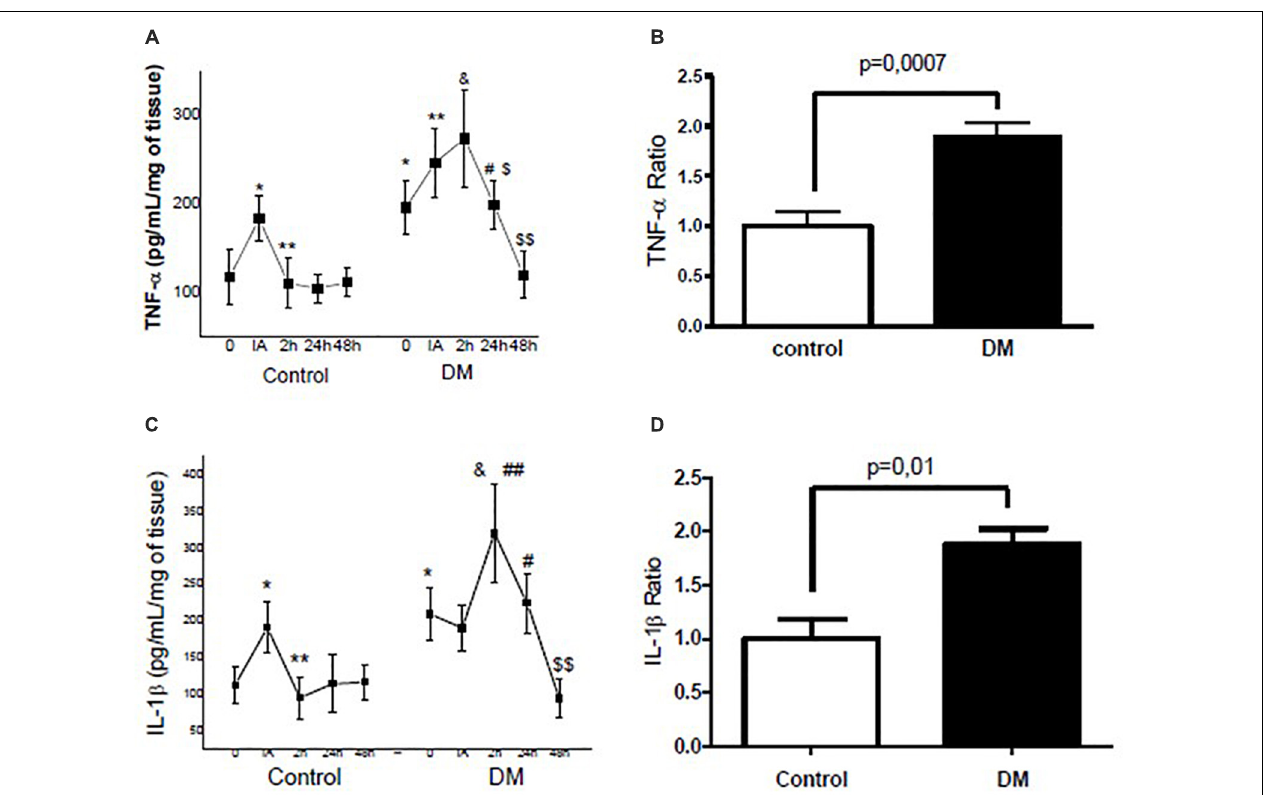
FIGURE 1 | (A) Kinetic profile of skeletal muscle tumor necrosis factor (TNF)- α concentrations in the control and diabetic animals evaluated before (0), immediately after (IA), and at 2 h (2), 24 h (24), and 48 h (48) after exercise. (B) TNF- α ratio of the integrated area under the curve (IAUC) between the control and diabetic rats. (C) Kinetic profile of skeletal muscle interleukin (IL)-1 β concentrations in the control and diabetic animals evaluated at 0, IA, and at 2, 24, and 48 h after exercise. (D) IL-1 β ratio of the IAUC between the control and diabetic rats. The values represent the means ± SE of seven animals per group. ∗ P < 0.05 versus 0 h (control); ∗∗ < 0.05 versus IA (control); & < 0.05 versus 2 h (control); # < 0.05 versus 24 h (control); $ < 0.05 versus 2 h (DM); ## < 0.05 versus IA (DM); $$ < 0.05 versus 24 h (DM).